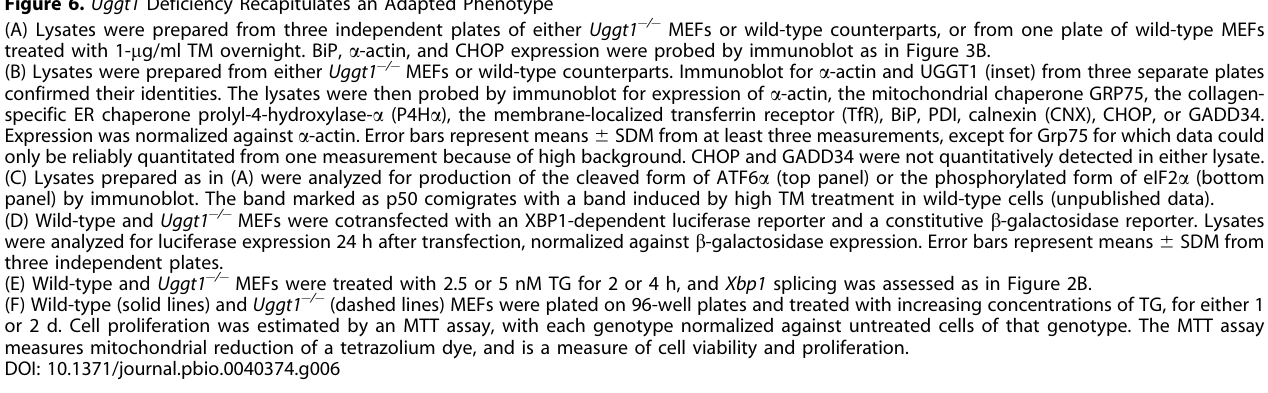
Figure 6. Uggt1 Deficiency Recapitulates an Adapted